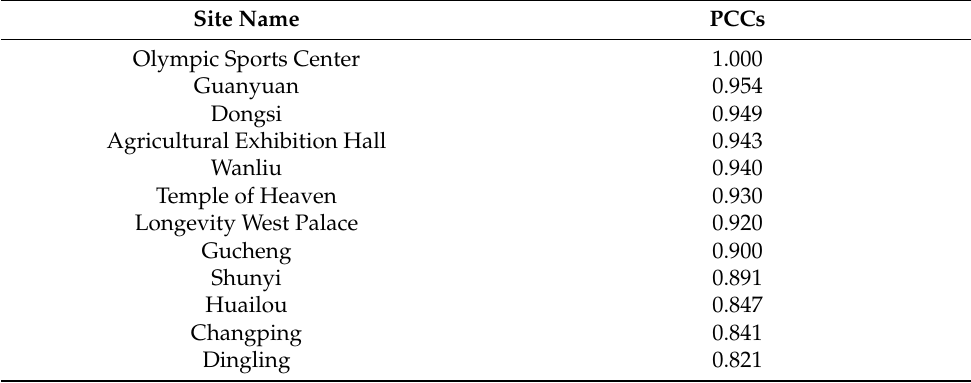
Table 4. PM 2.5 correlation of each station.